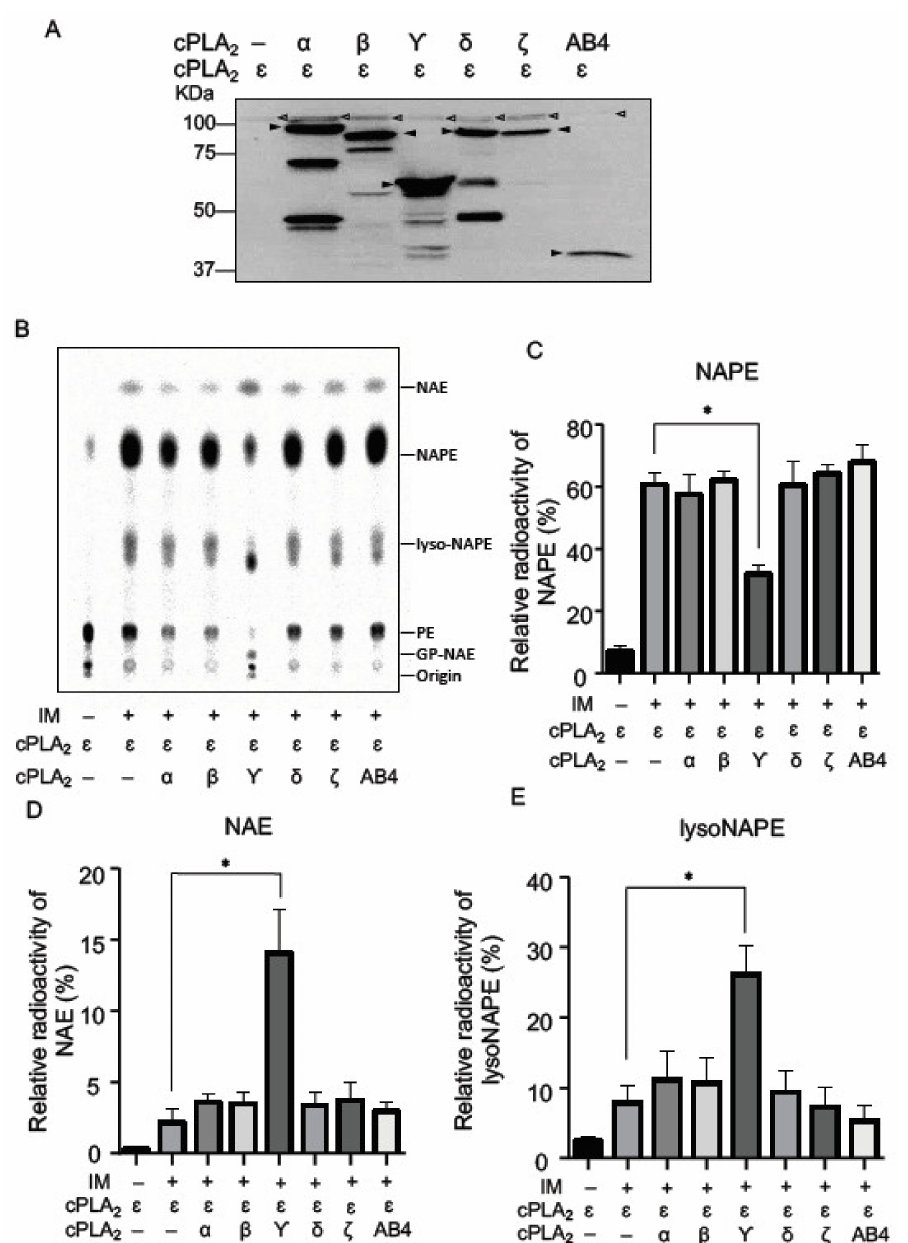
Figure 3. Metabolic labeling with [ 14 C]ethanolamine of the cells co-expressing cPLA 2 ε and one of the other isoforms. cPLA 2 ε /Tet-on cells were transfected with the insert-free vector or the expression vector harboring cDNA for the indicated FLAG-tagged cPLA 2 isoforms or ABHD4 (AB4). Their expressions were confirmed by Western blotting using anti-FLAG antibody ( A ). Arrowheads indicate the positions of the deduced molecular mass of each isoform and ABHD4. The cells were labelled with [ 14 C]ethanolamine, followed by the treatment with ionomycin (IM). Total lipids were then analyzed by TLC ( B ). The positions of the origin and authentic compounds are shown. The relative radioactivities of NAPE ( C ), NAE ( D ), and lysoNAPE ( E ) are shown (mean values ± S.D., n = 3). * p <